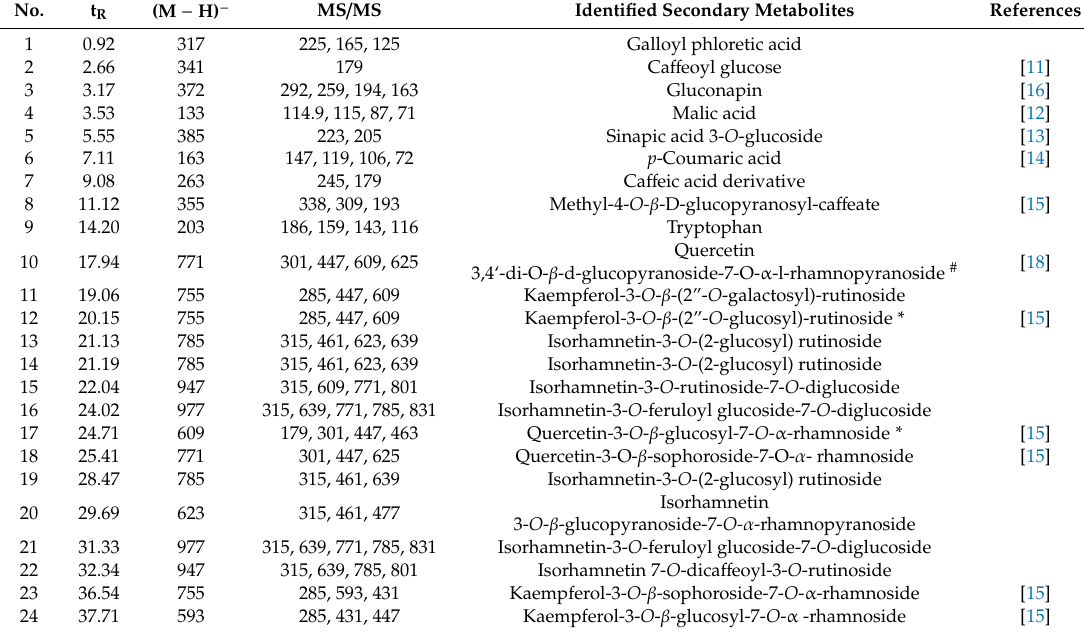
Table 1. Secondary metabolites from the bioactive fraction (MS-3) of Moricandia.